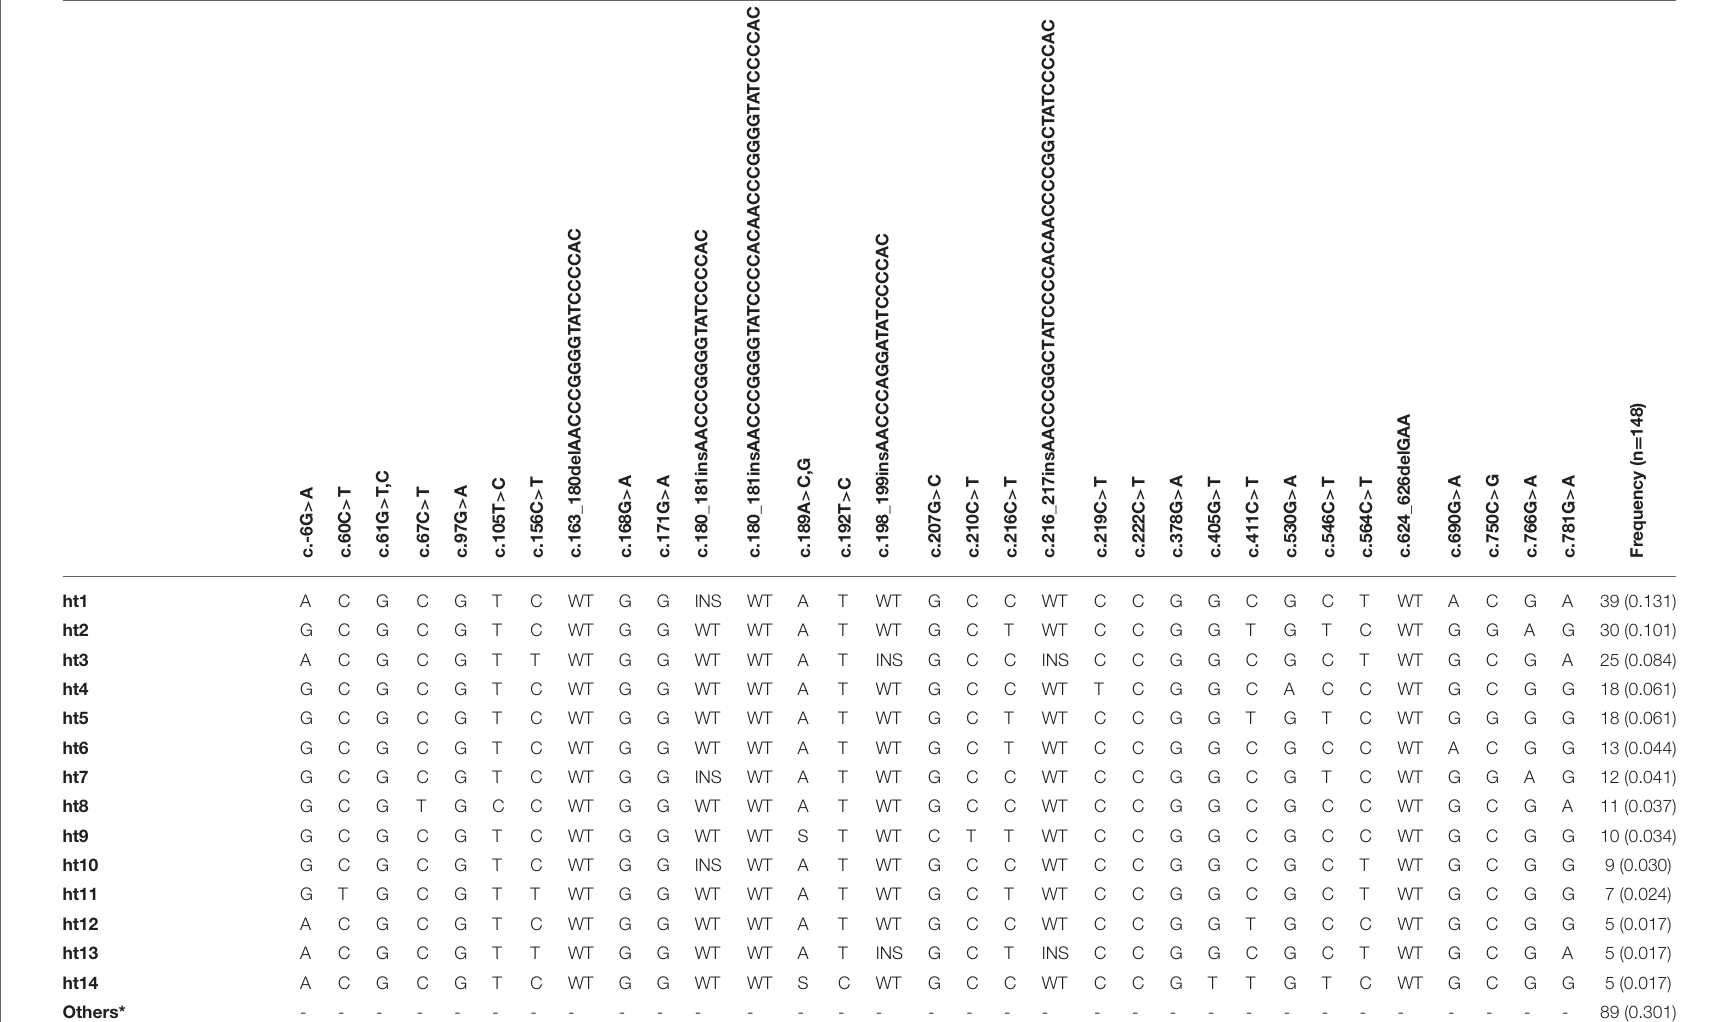
TABLE 3 | Haplotype frequency of 34 PRNP polymorphisms in